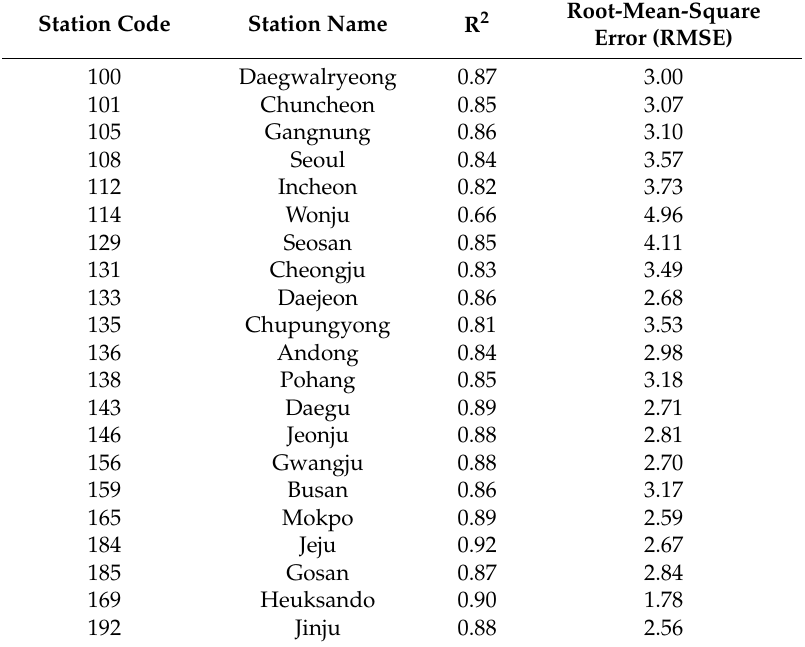
Table 1. Statistical analysis for comparison of daily observed and calculated solar-radiation data for 21 stations of South Korea